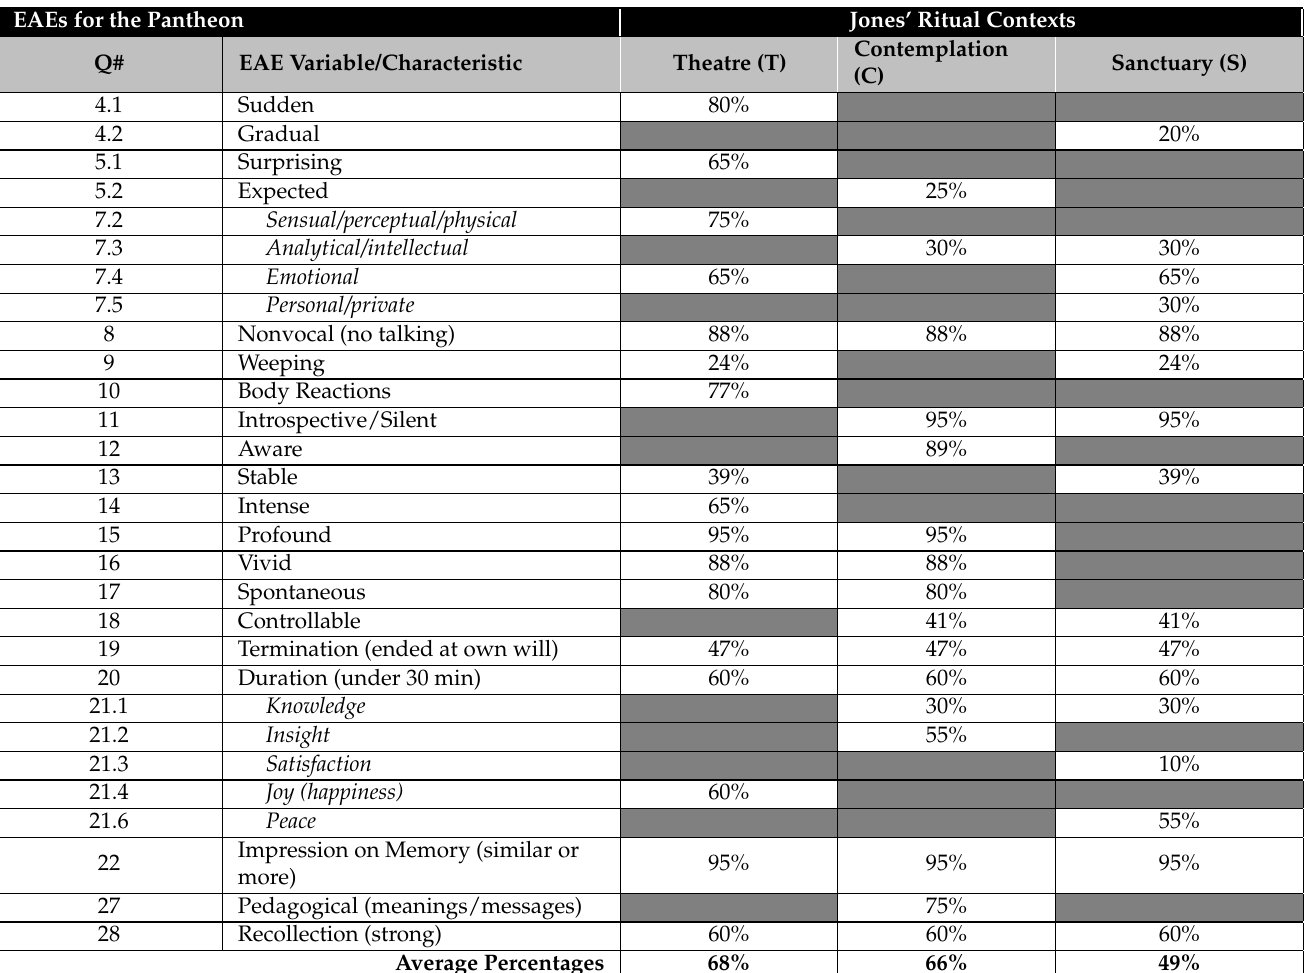
Table 5. Summary of the subjective experience at the Pantheon based on EAE survey data. The EAE survey question numbers are organized sequentially and charted against Jones’ three ritual contexts. All percentages are based on the size of the survey group for the Pantheon discussed earlier (n = 20). Some ritual contexts use the same EAE question based on the three stage statistical methodology outlined